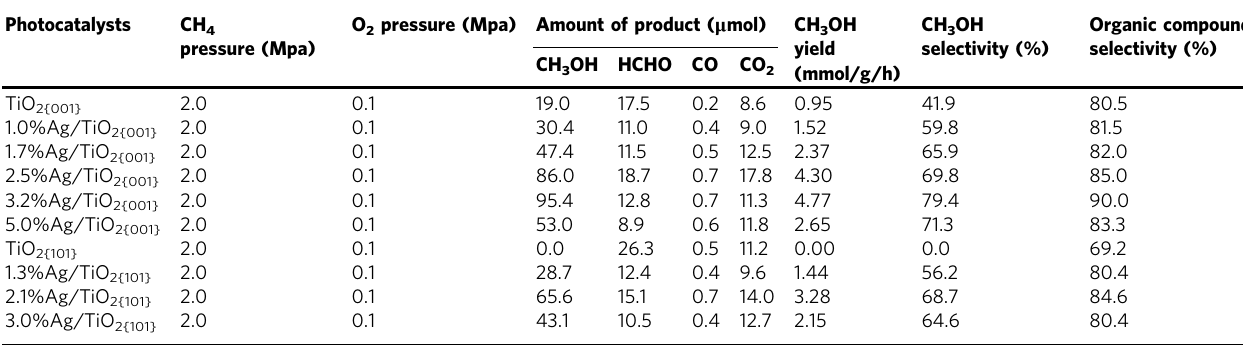
Comparison of photocatalytic activity of TiO 2 {001} and TiO 2 {101} with and without a series of Ag loadings for the aqueous-phase photooxidation of CH 4 by O 2 . Reaction conditions: 10mg Ag/TiO 2 , 100mL water, 25°C reaction temperature, 2h reaction time, light source: 300W Xe lamp, light intensity of 450mWcm − 2